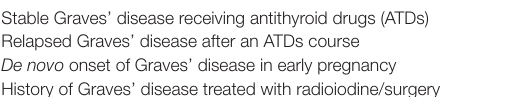
TAble 1 | Clinical scenarios of Graves’ disease in